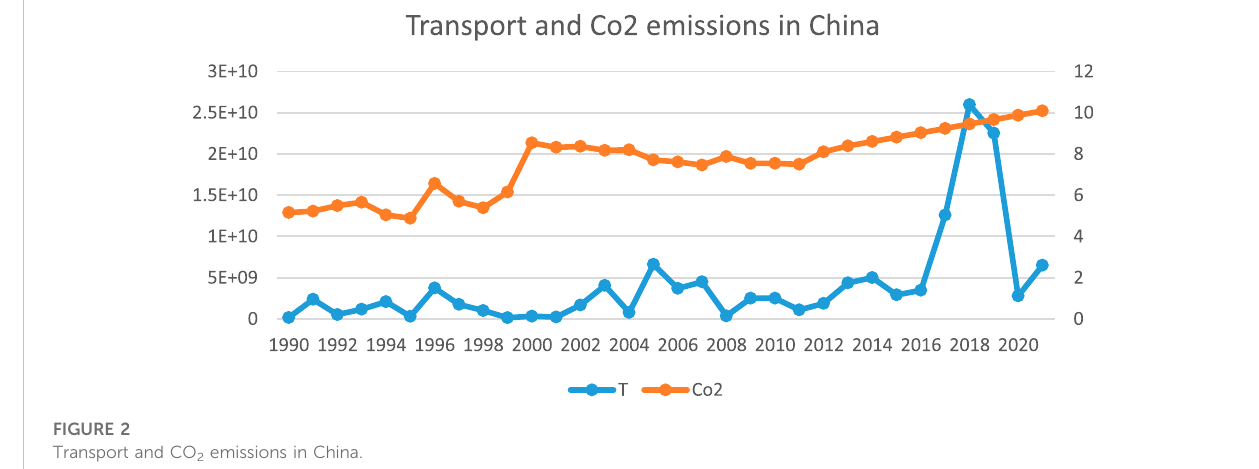
FIGURE 2 Transport and CO 2 emissions in